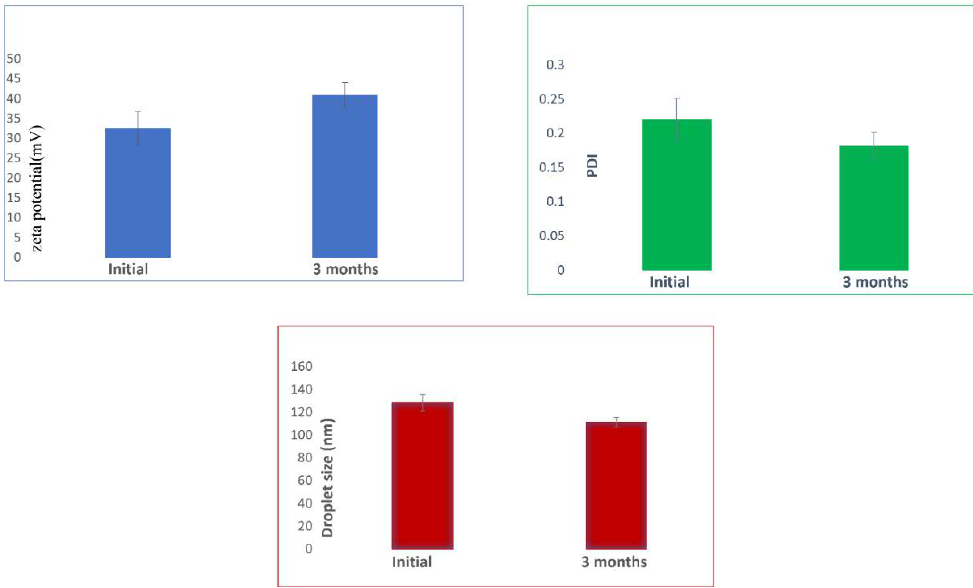
Figure 11. Stability assessment after storage of nanoemulsion at room temperature for three months.